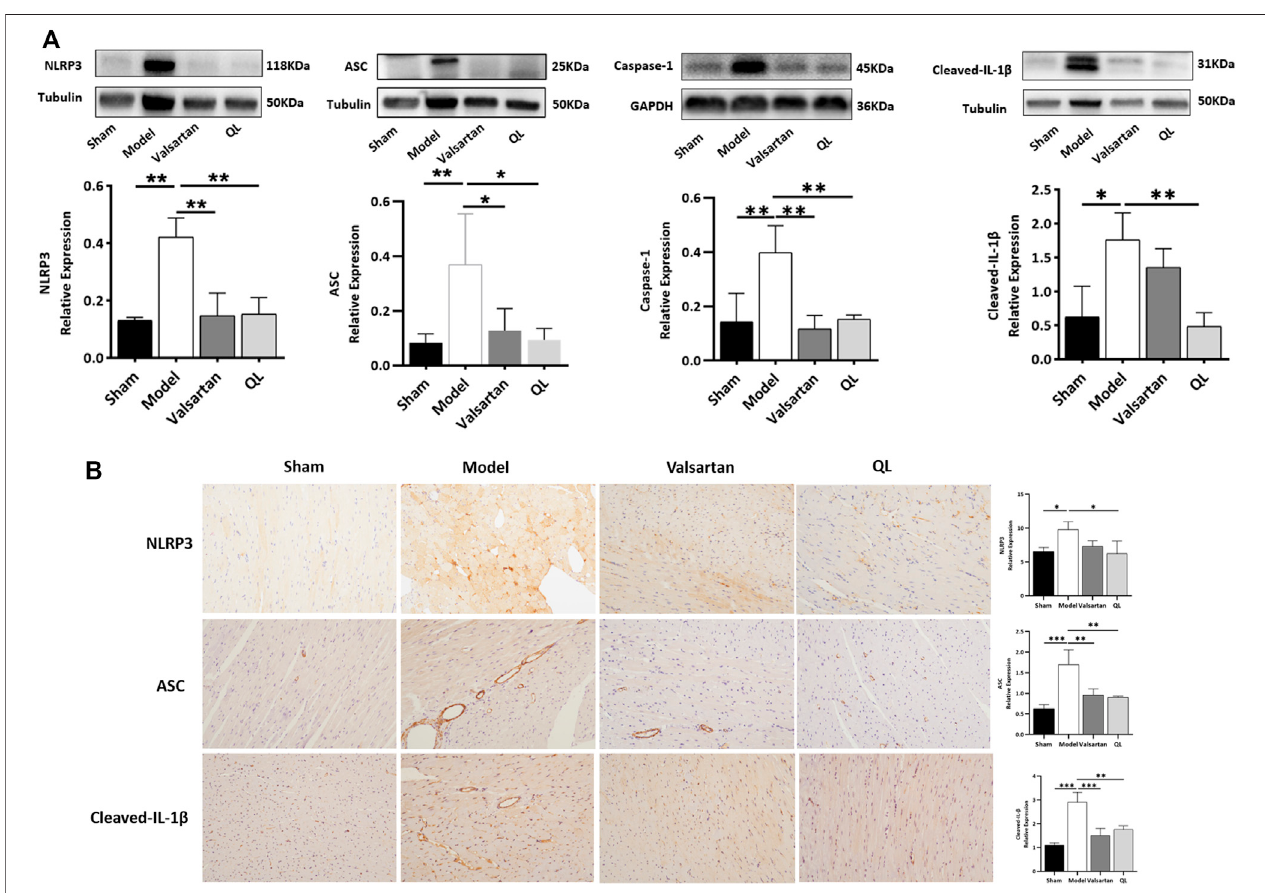
FIGURE 6 | QL inhibits in fl ammasome generation in HF (A) Western blot analysis of NLRP3, ASC, caspase-1, and cleaved-IL-1 β protein expression in the cardiac tissue. (B) ImmunochemicalstainingofNLRP3,ASC,andcleaved-IL-1 β .TubulinorGAPDHwasdetectedastheloadingcontrol.NLRP3:nod-likereceptorpyrindomain 3, ASC: apoptosis-associated speck-like protein, and IL-1 β : interleukin 1 β . The data are the mean ± standard deviation ( (cid:1) x ± s ) (n = 3 or 4 per group) * p < 0.05, ** p < 0.01, and *** p < 0.001.